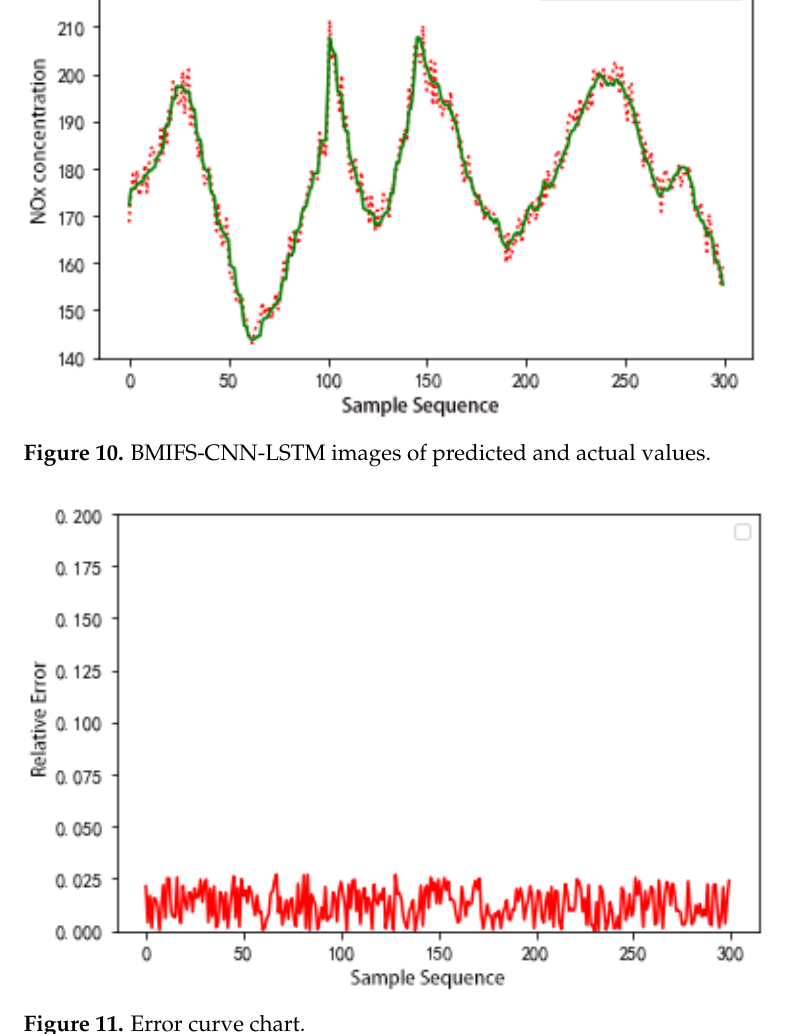
Table 4. Comparison of model error statistics.